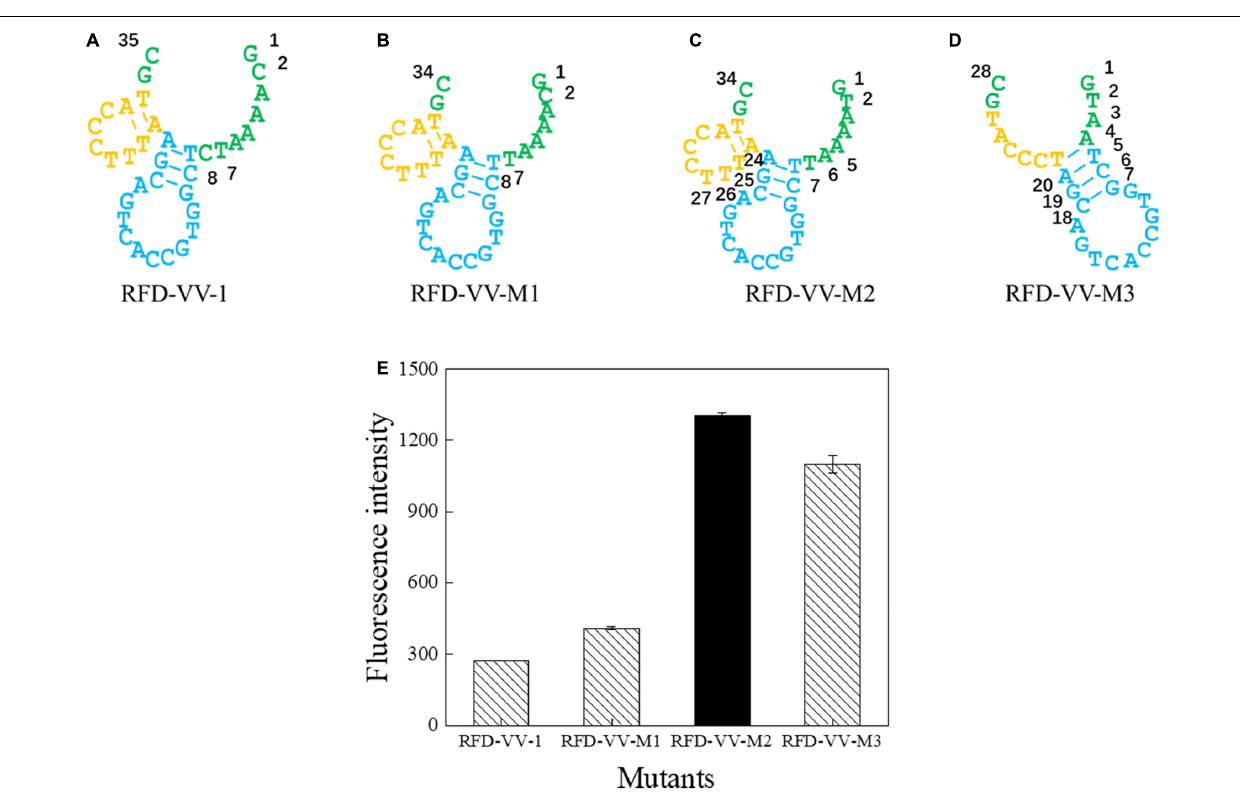
Frontiers in Microbiology |